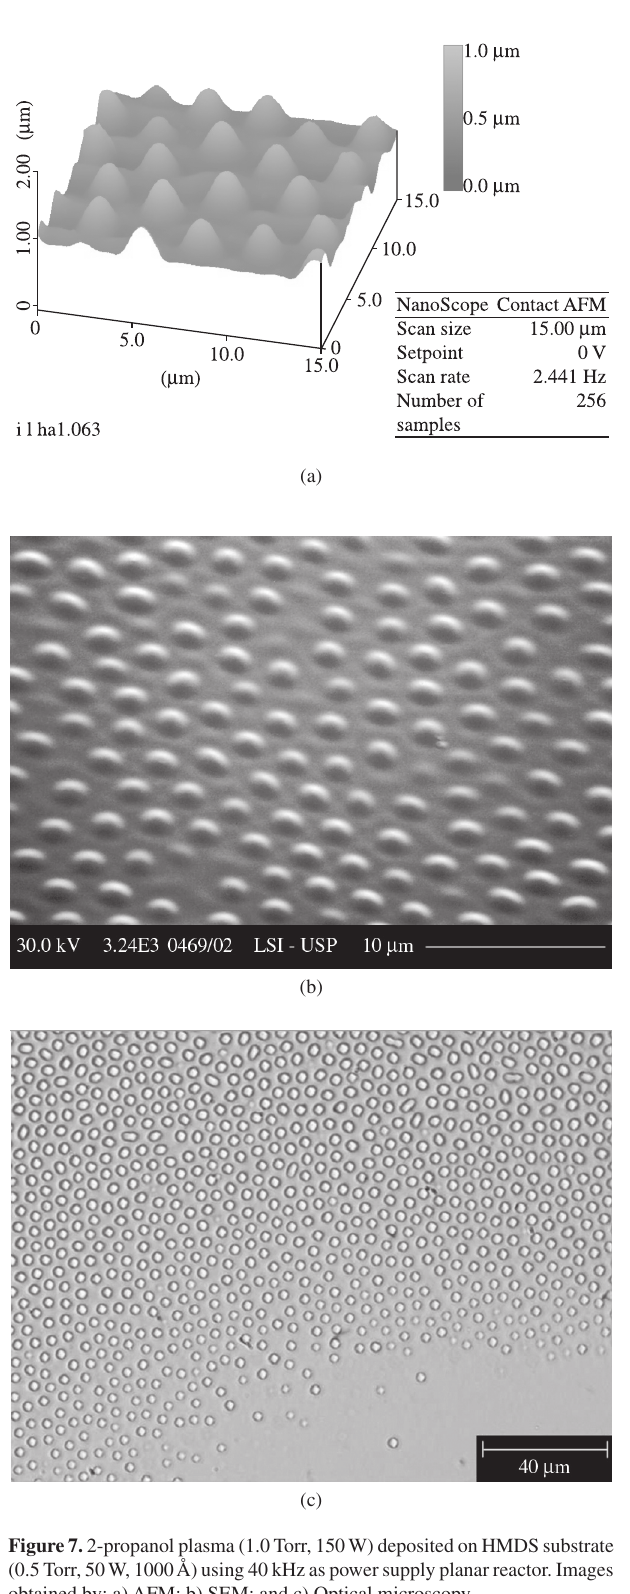
by plasma polymerization. For both reactors the use of 13.56 MHz power supply, for all reagents, made it difficult to obtain films and usually the produced films are less polar. A possible explanation for